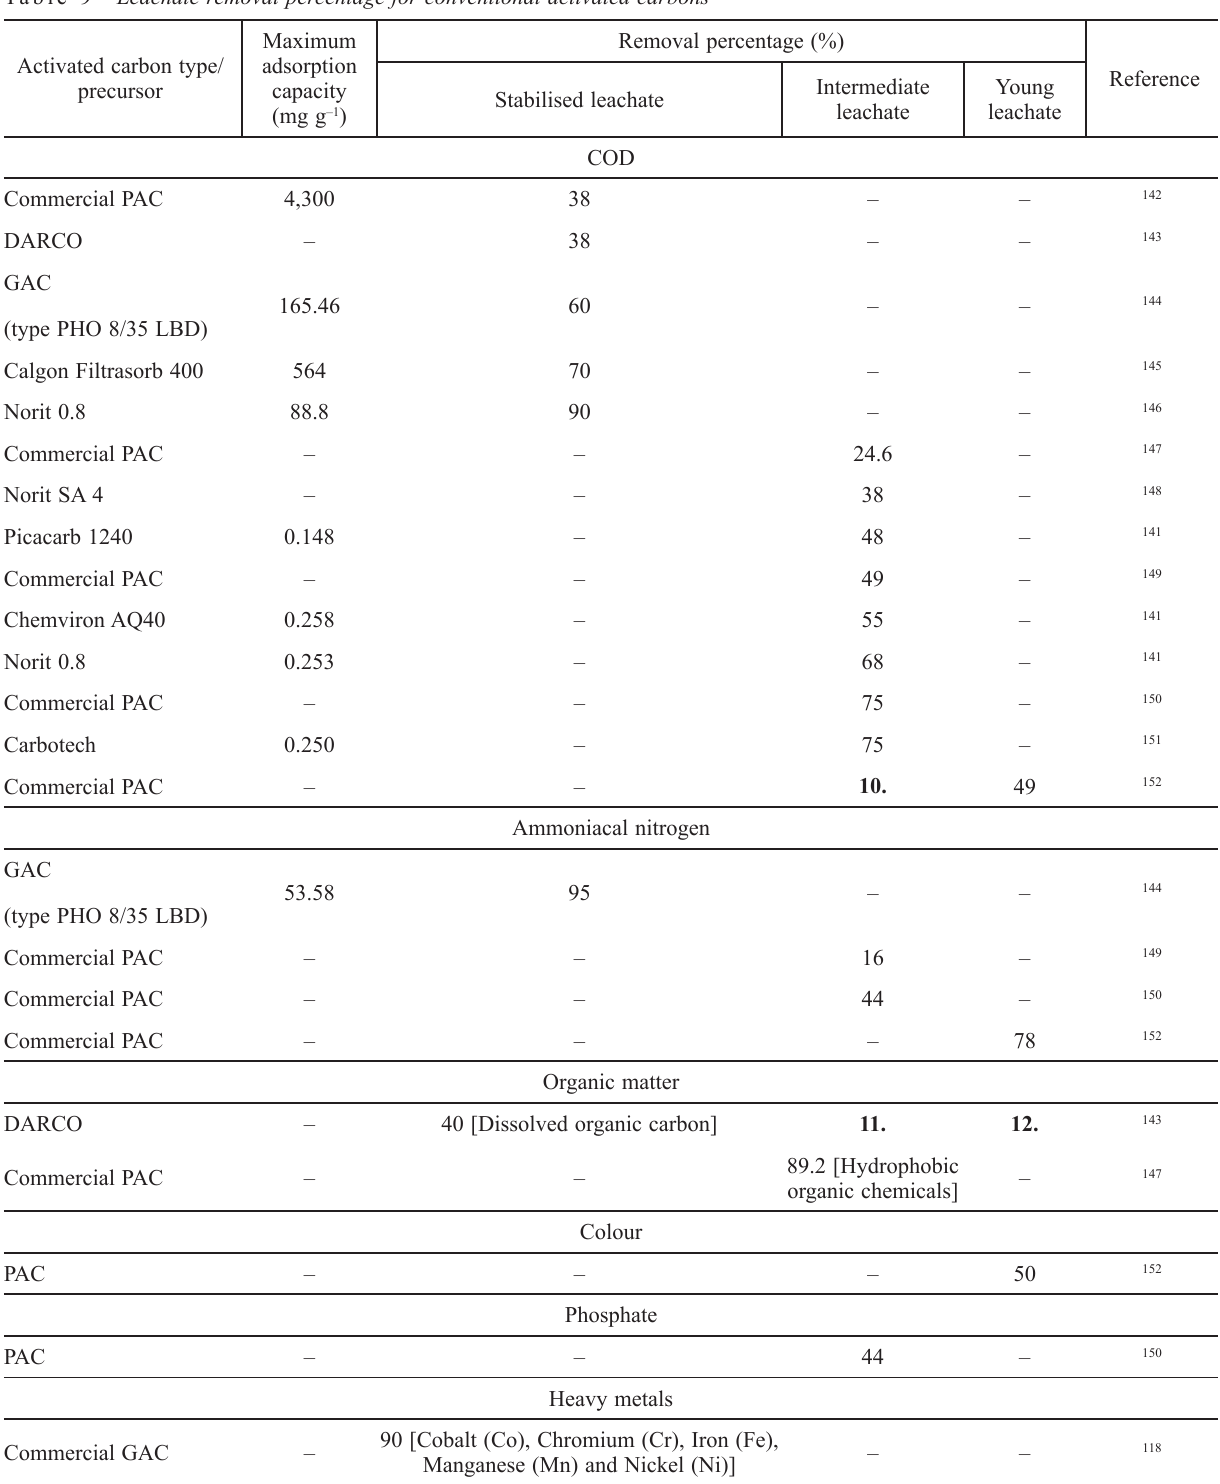
Table 9 – Leachate removal percentage for conventional activated